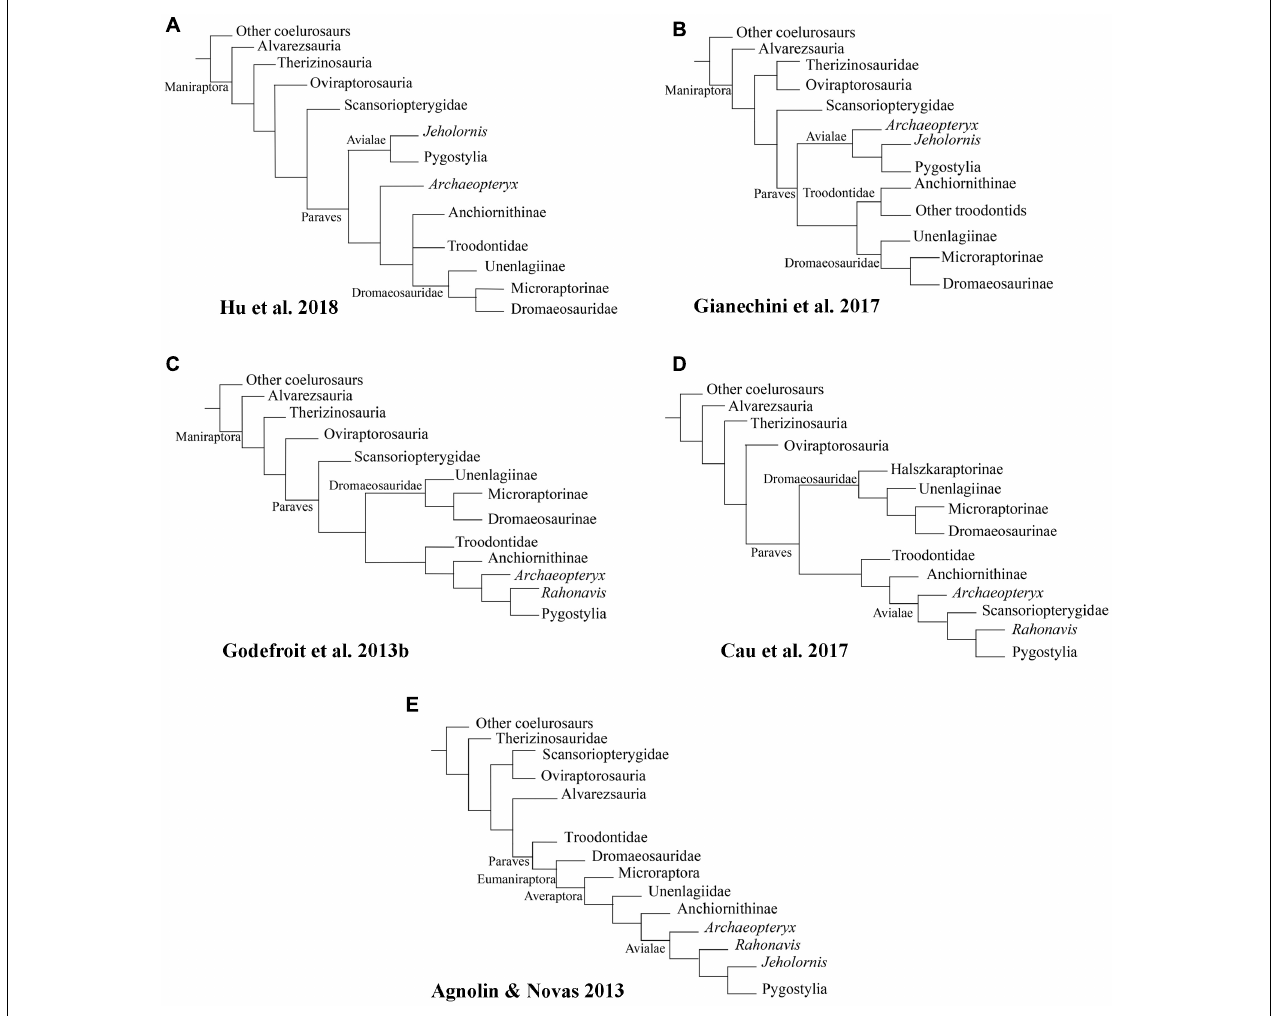
FIGURE 2 | Simplified results of recent paravian phylogenetical analyses: (A) Gianechini et al. (2017); (B) Hu et al. (2018); (C) Godefroit et al. (2013b); (D) Cau et al. (2017); (E) Agnolin and Novas